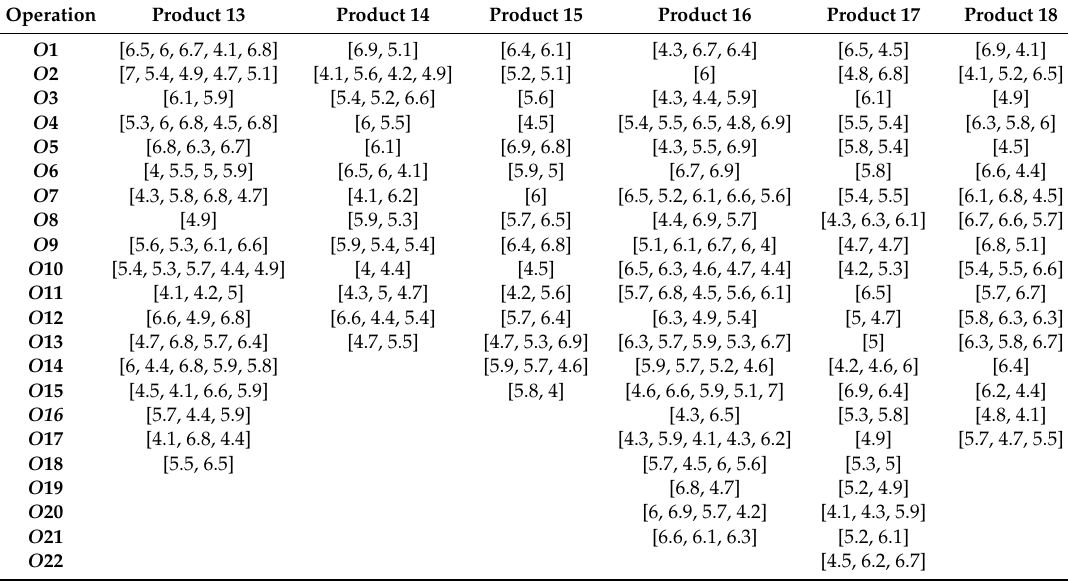
Table A3. Working power for the operations processed on machines in case